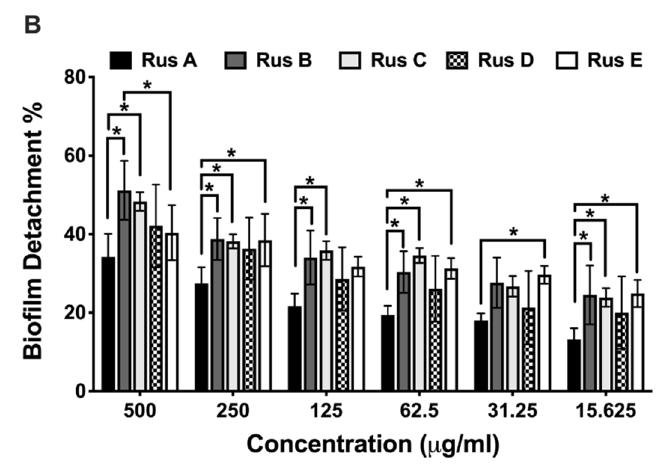
Figure 5. Antibiofilm inhibition activity. Effect of different concentrations (500–15.625 µ g/mL) of the isolated Caralluma quadrangular compounds ( Rus A – E ) on MRSA USA300 biofilm. Results are expressed as mean biofilm inhibition % ± standard error ( A ) and mean biofilm detachment % ± standard error ( B ). * Indicates that the difference is significant at p < 0.05 (two-way ANOVA, Tukey’s post-hoc test). Table 1. IC50 of the five isolated Caralluma quadrangula compounds ( Rus A – E ) against MRSA USA300 biofilm. Biofilm Inhibition Biofilm Detachment LogIC50 ± SE